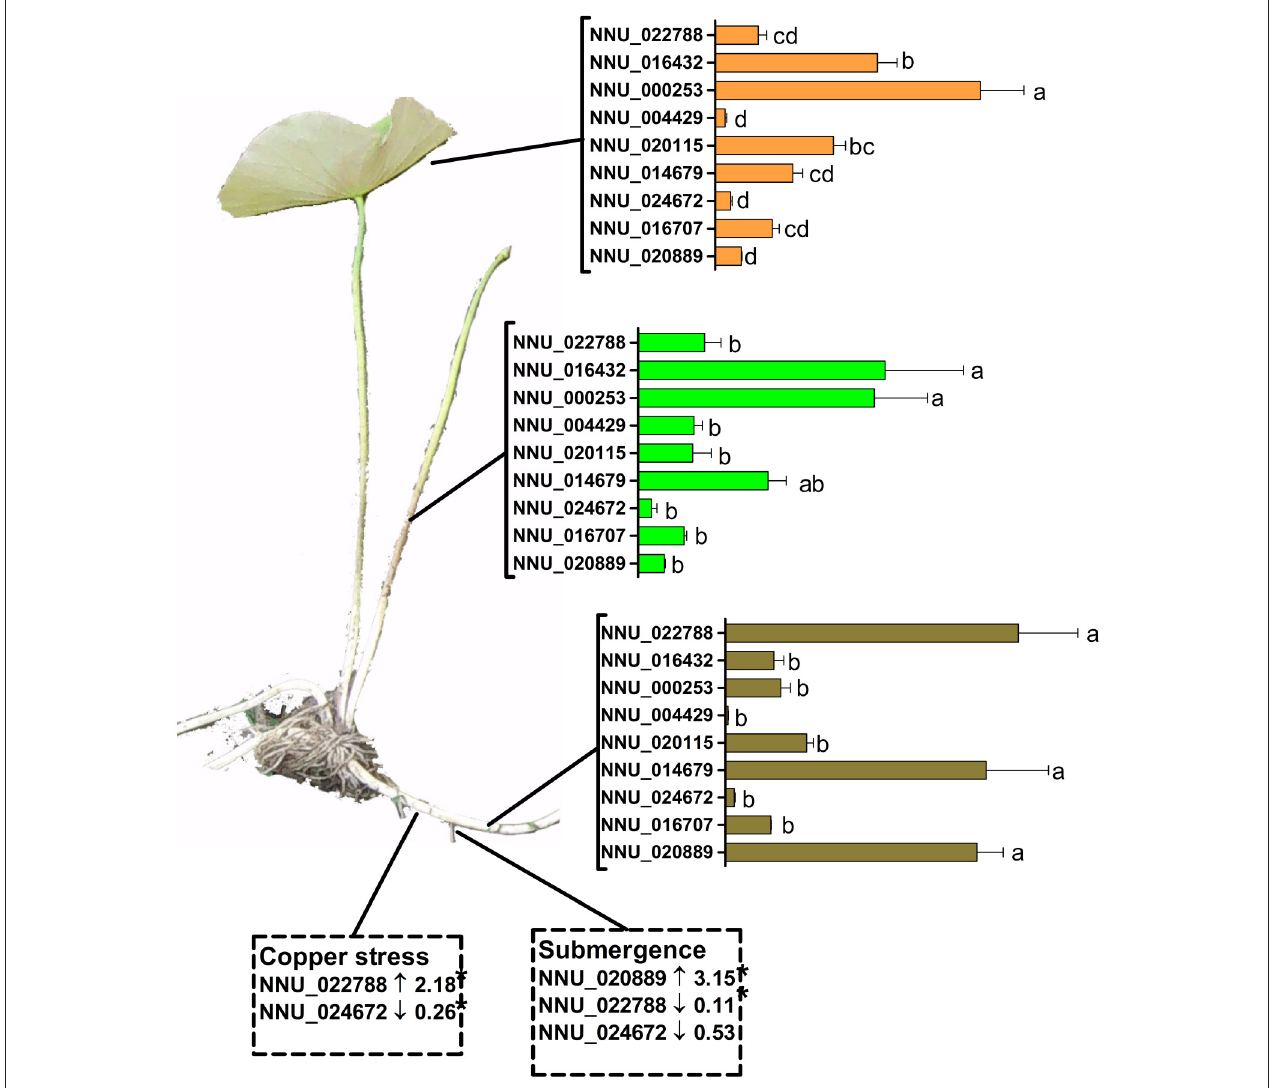
FIGURE 8 | Validation of expression of selected NnTPS genes in various tissues and in rhizome upon exogenous stimuli. Tissues including leaf, petiole, and rhizome were sampled from 2 month old lotus seedlings. Meanwhile, lotus seedlings were treated with submergence stress or copper stress for 24h and then rhizome was sampled. The sample without 5mm copper treatment or submergence treatment was the control (Con). Gene expression was analyzed by real-time RT-PCR. The relative transcript abundance was normalized using lotus actin gene. Values are means ± SE of at least four independent experiments. Bars with different letters are significantly different at P < 0.05 according to Turkey’s multiple range test. Fold changes of genes under copper stress and submergence treatment were values relative to control samples. Asterisks indicate significant differences compared with control sample at P < 0.05 levels according to t- test.